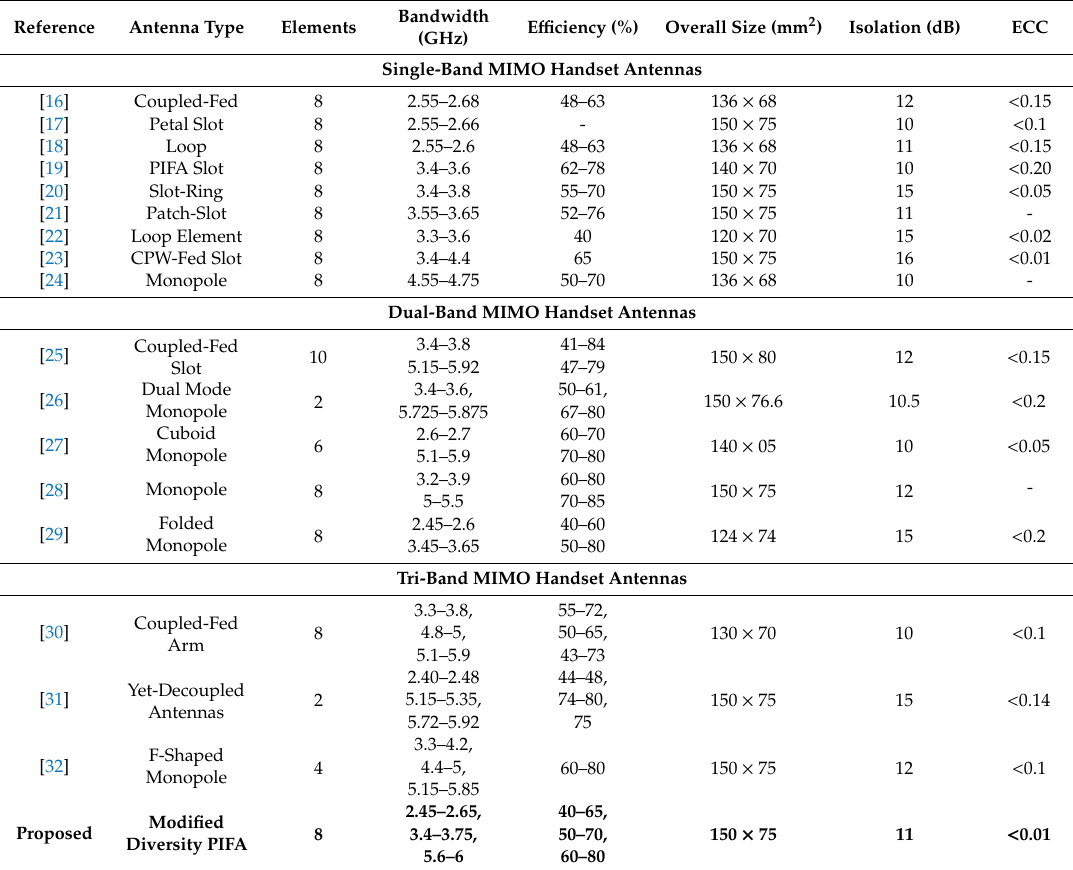
Table 2. Comparison of the design characteristics with the referenced handset antennas. MIMO: